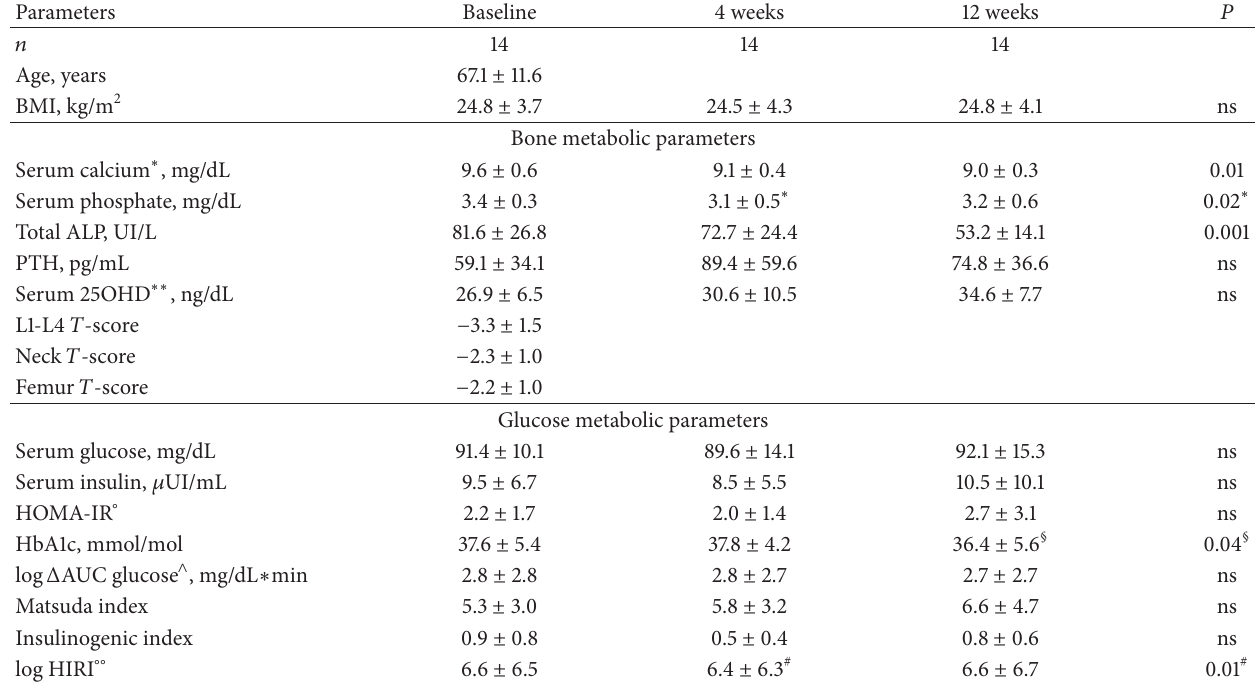
Table 1: Clinical and biochemical features of patients treated with denosumab at baseline and at 4 and 12 weeks after denosumab injection.